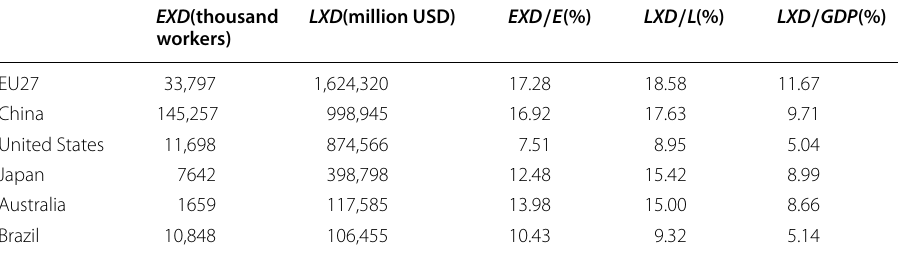
Table 2 Employment impact of direct exports, 2014. Source: Author’s calculations based on the WIOD EXD (thousand workers)